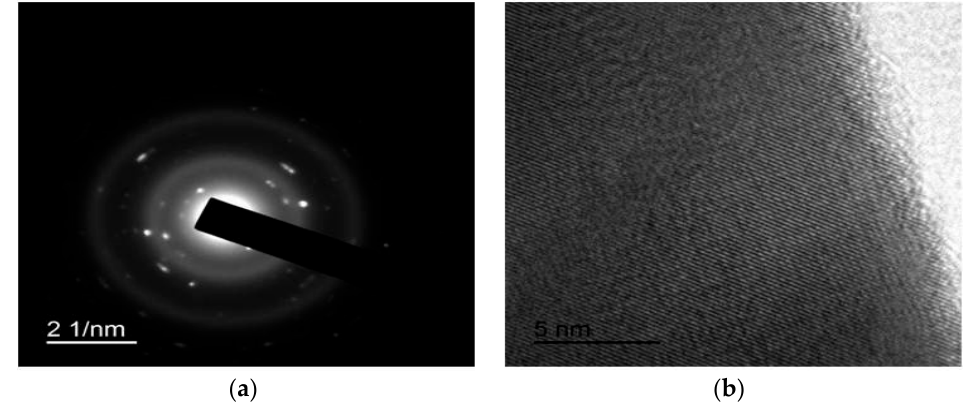
Figure 6. ( a , b ) High resolution transmission electron microscope (HR-TEM) images of titanium nanostructures TiO 2 -NPs.